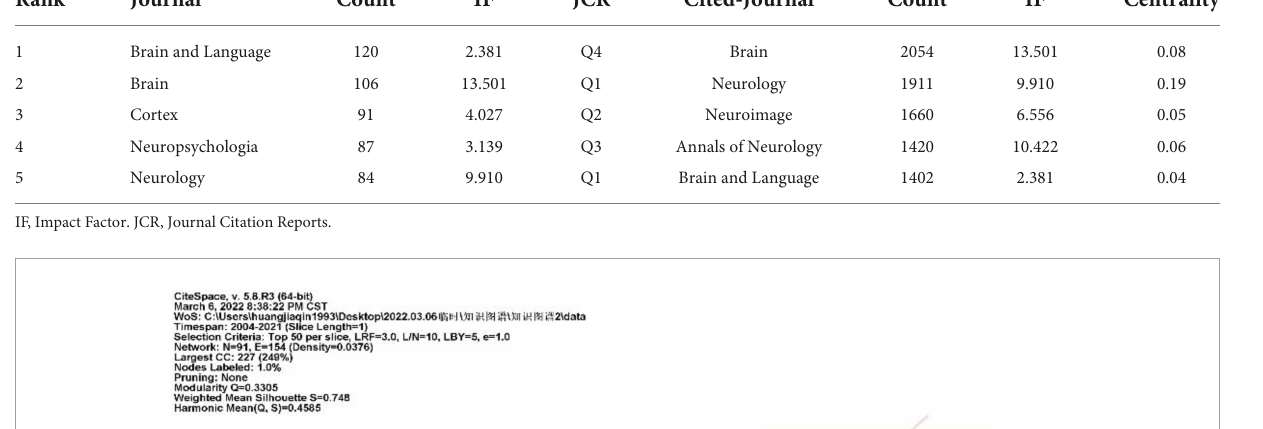
FIGURE5 Disciplines involved in neuroimaging on aphasia, shown as a network of subject categories.